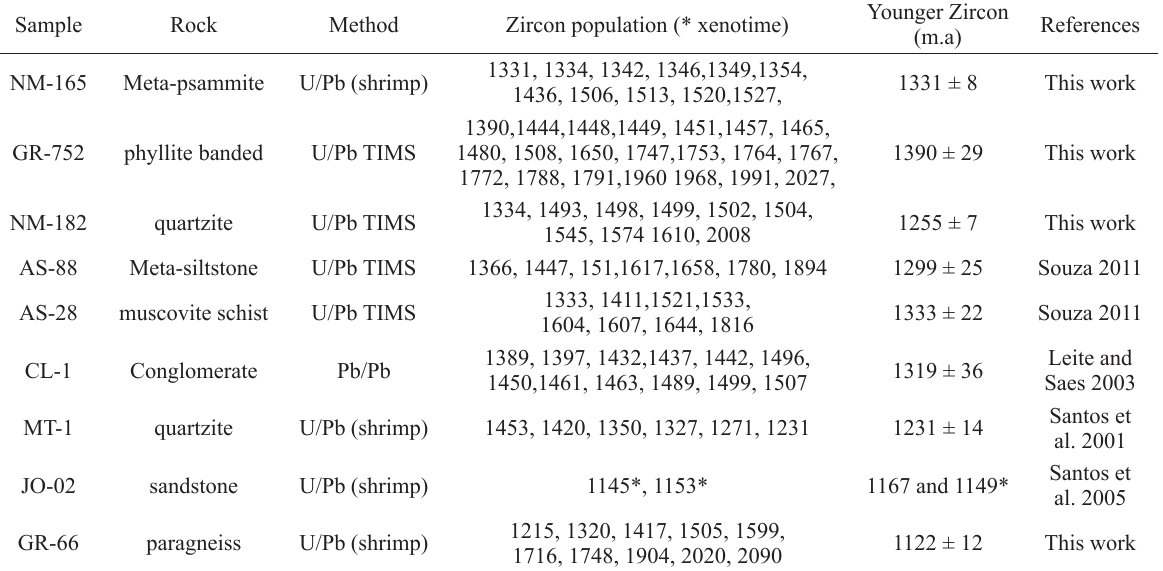
Summary of U-Pb detrital zircon data of the Nova Brasilândia and Aguapeí